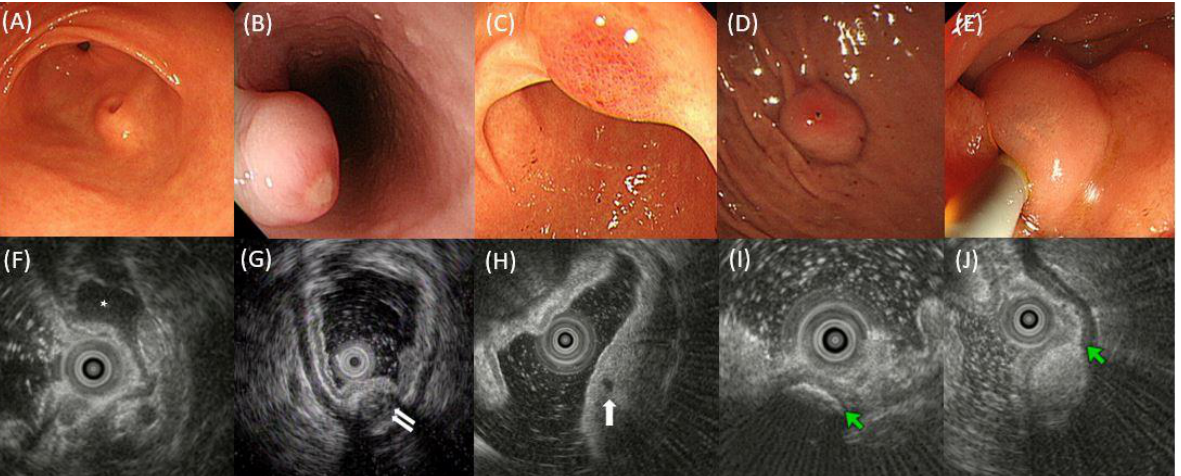
Figure 2. Examples of the endoscopic and EUS findings of SELs. ( A ) Umbilication or central dimpling, ( B ) erosion or ulcer, ( C ) erythema, ( D ) hemorrhagic spot, and ( E ) translucidity. ( F ) EUS image showing a homogeneous hypoechoic SEL (asterisk) with a distinct border; ( G ) EUS image showing an SEL involving muscle propria layer (white arrows) with heterogeneity, mixed echogenicity, indistinct border, and deep attenuation; ( H ) EUS image showing anechoic foci (white arrow); ( I ) EUS image showing hyperechoic foci (green arrow) with acoustic shadowing that suggests calcification; ( J ) EUS image showing an SEL involving submucosal layer (green arrow indicates hyperechoic submucosal layer) with hyperechoic echogenicity, homogeneity, and distinct border. EUS, endoscopic ultrasonography; SEL, subepithelial lesion.